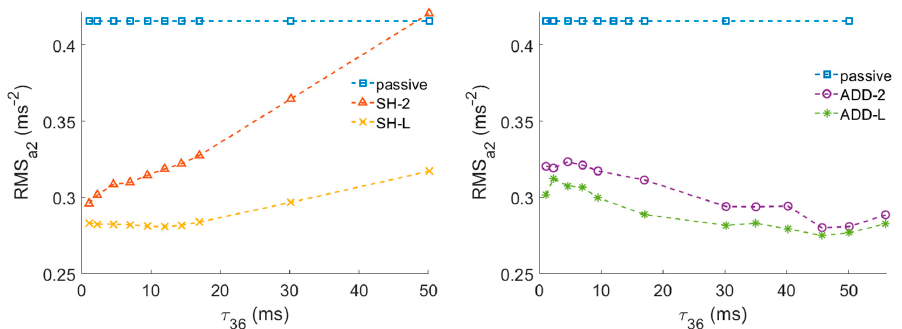
Figure 7. Damper force drop response time τ 36 effect for passive mode, SH-2 and SH-L algorithms ( left ) and passive mode, ADD-2 and ADD-L algorithms ( right ), HILS results. For SH-2 and SH-L algorithms, the response time for the damping force drop is sig- nificantly more critical than for the damping force rise. It is caused by the input electric current being switched to 𝐼 (cid:3040)(cid:3028)(cid:3051) = 2 A when the damper piston velocity 𝑣 (cid:2870) − 𝑣 (cid:2869) is zero (when the force for activated and non-activated states is 0 N) and switched to 𝐼 (cid:3040)(cid:3036)(cid:3041) = 0 A when the piston velocity and damping force are non-zero, see Figure 8 left. In Figure 8 right, it can be seen that the artificial long response time 𝜏 (cid:2871)(cid:2874) makes the function of the ADD-2 algorithm similar to the SH-L algorithm function. This similarity explains the im- portance of a long force drop response time for good results from the ADD-2 and ADD-L algorithms.